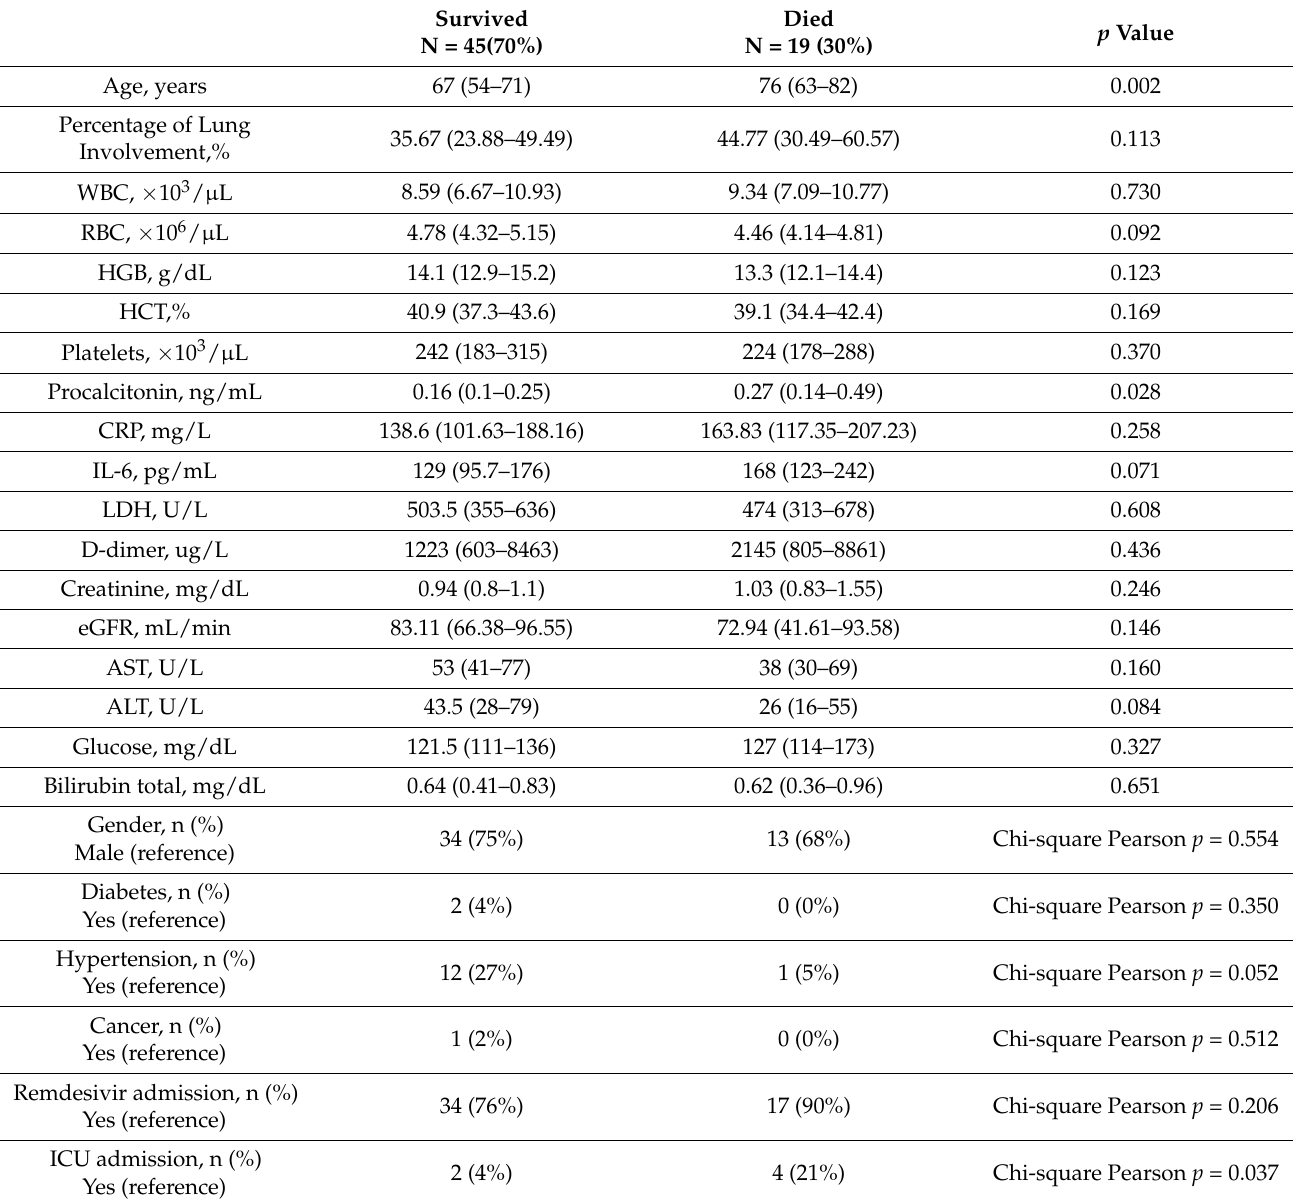
Table 3. Characteristic of surviving group compared to the patients who